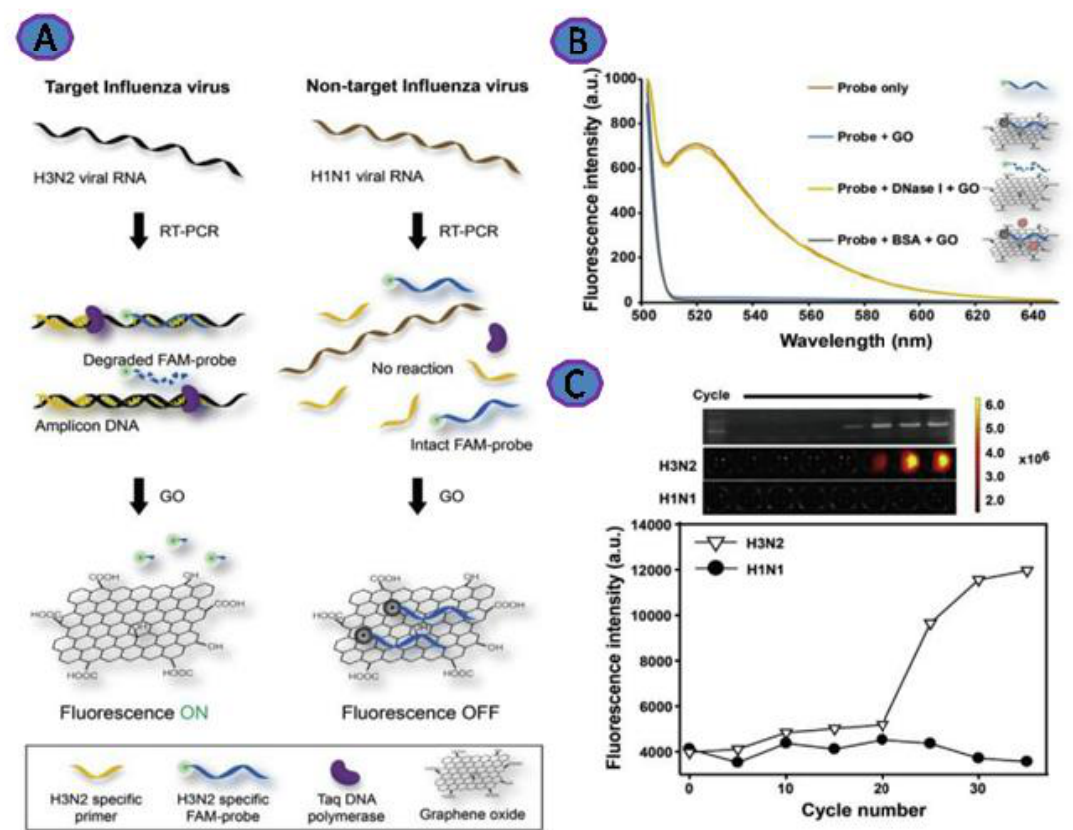
Figure 5. ( A ) Representation of fluorescence detection of Influenza virus RNA via GO and Taq polymerase’s 5 (cid:48) to 3 (cid:48) exonuclease activity during RT-PCR; ( B ) representation of the relationship between the fluorescence emission spectra of the FAM-DNA probe and the DNase I after GO incubation ( λ ex = 485 nm); ( C ) with each PCR cycle, the fluorescence of the FAM-DNA probe increased. RT-PCR was performed on H3N2 (target) and H1N1 (non-target) viral RNAs using H3N2 hemagglutinin gene-specific primers and the FAM-DNA probe. Reprinted with permission from Ref. [38]. Copyright 2022, Elsevier B.V.